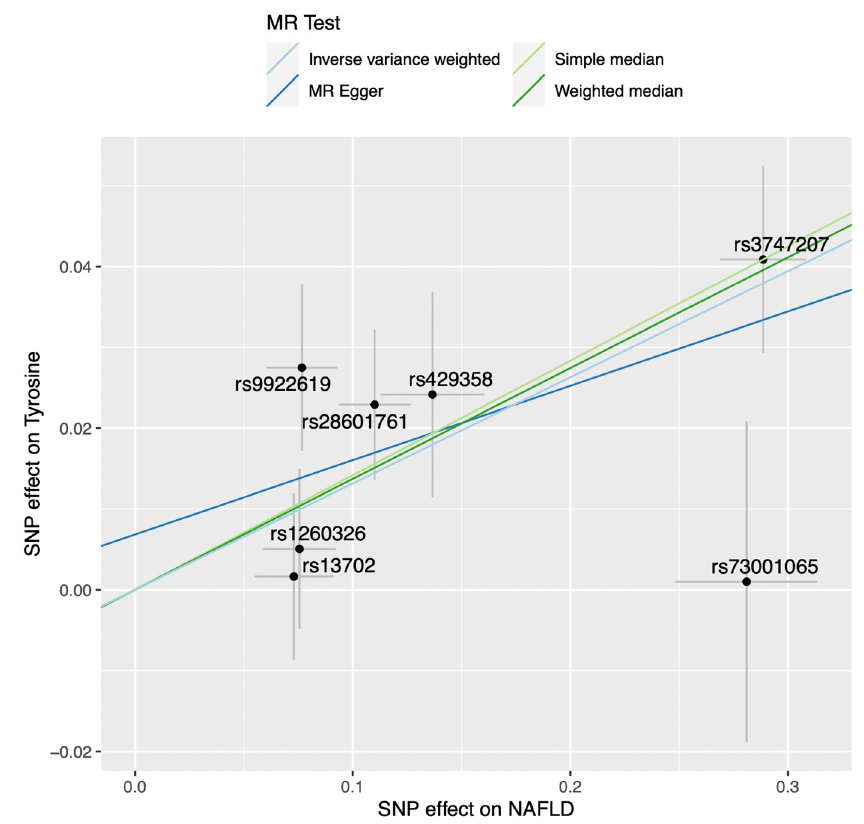
Figure 2. A Mendelian randomization study of genetically predicted non-alcoholic fatty liver disease and plasma levels of tyrosine. Scatter plot showing the estimated effect sizes of each of the seven genetic loci associated with NAFLD on NAFLD and blood tyrosine levels and the regression slopes of four MR methods (inverse-variance weighted, simple median, weighted median, and MR-Egger).